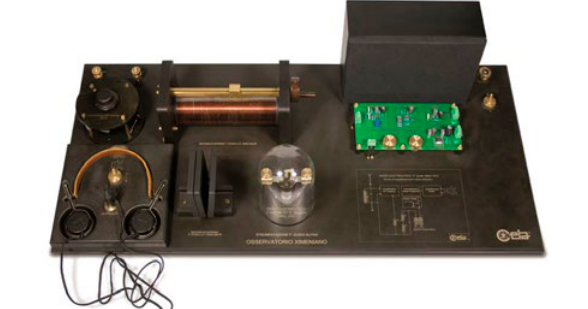
Figure 4. Radio receiver built in 1912, the model of it is in the booklet Father Alfani dedicated to Marconi during his visit held in 1912. 4 The diode, head-phones and the capacitor are original.